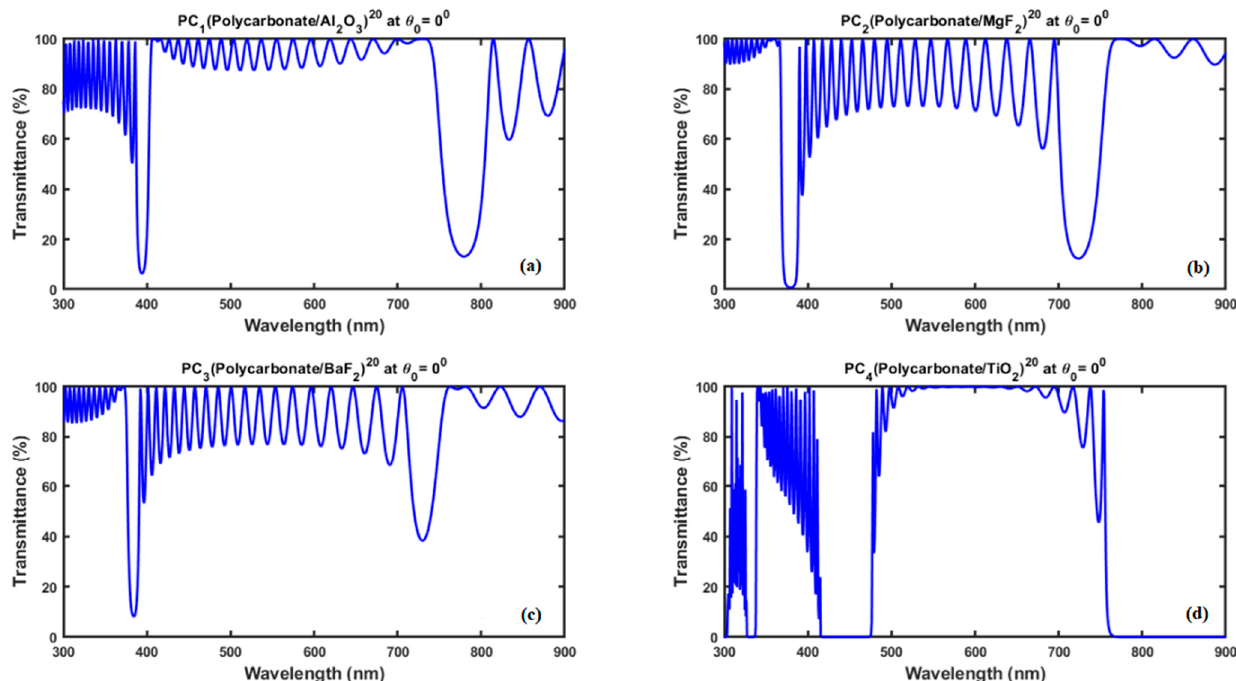
Figure 4. The calculated transmission spectra of 1D polycarbonate-based ternary photonic structures PC 1 , PC 2 , PC 3 and PC 4 as a function of wavelength at normal incidence are shown: ( a ) polycarbonate/Al 2 O 3 , ( b ) polycarbonate/MgF 2 , ( c ) polycarbonate/BaF 2 and ( d ) polycarbonate/TiO 2